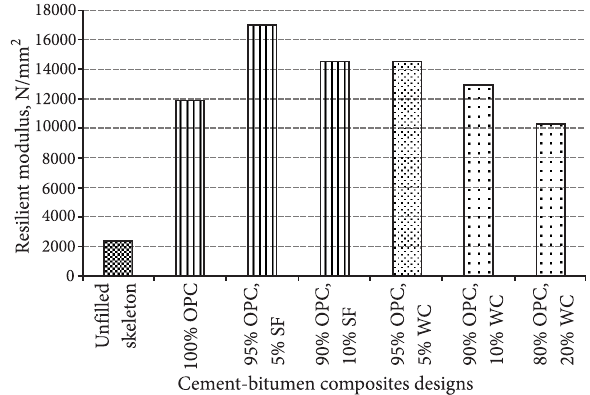
Fig. 4. Indirect tensile stiffness modulus performance of cement-bitumen composites designs